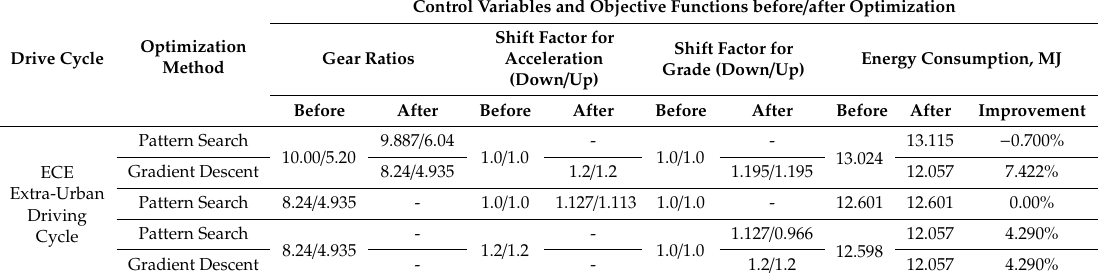
Figure 14. ECE Extra-Urban driving cycle on uphill driving conditions: ( a ) Tracking response; ( b ) Gear distribution before optimization and ( c ) Gear distribution after optimization. Table 8. Optimization of gearshift schedule in relation to road grade of two-speed transmission system in an EV model on ECE Extra-Urban driving cycle associated with road grade information.